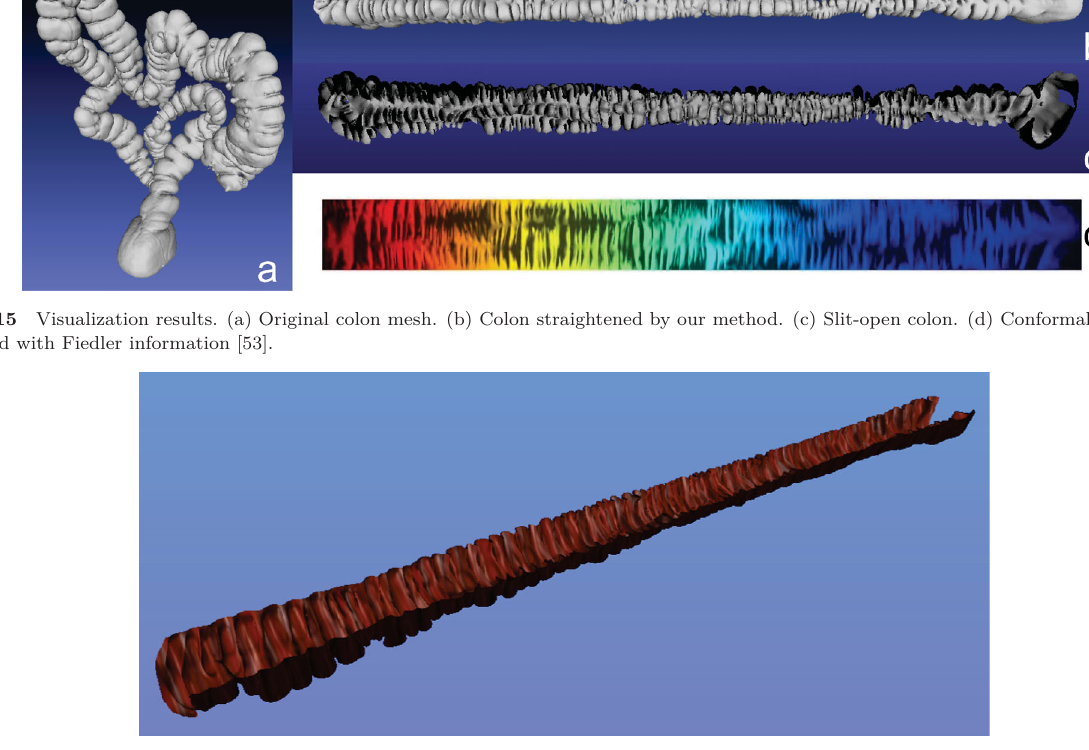
Fig. 16 Visualization of the interior of a straightened colon. Geometry and synthesized texture are displayed